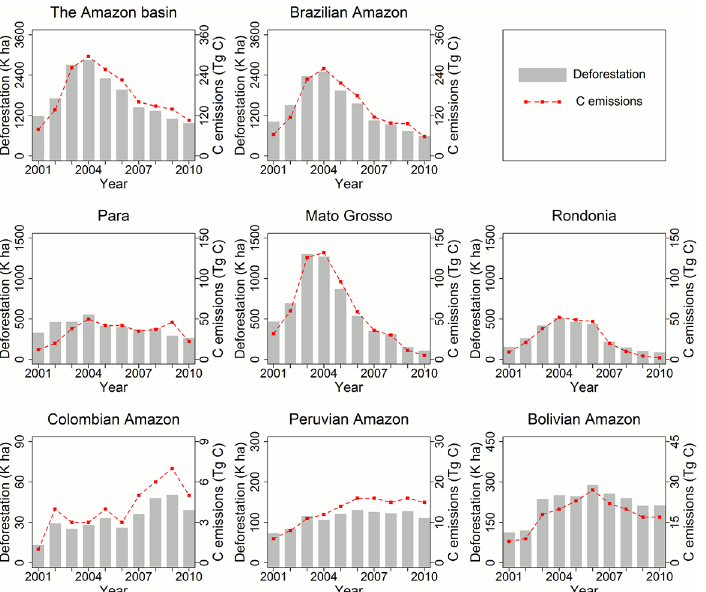
Fig 3. Trends of deforestation and associated carbon emissions from 2000 to